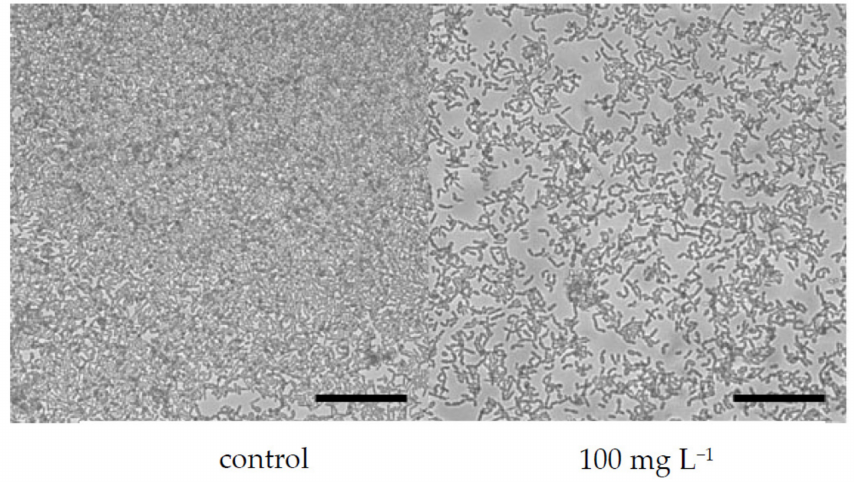
Figure 4. Effect of fluconazole on C. albicans ATCC 2091 biofilm formation (visualized by a Cellavista device), scale bar 100 µ